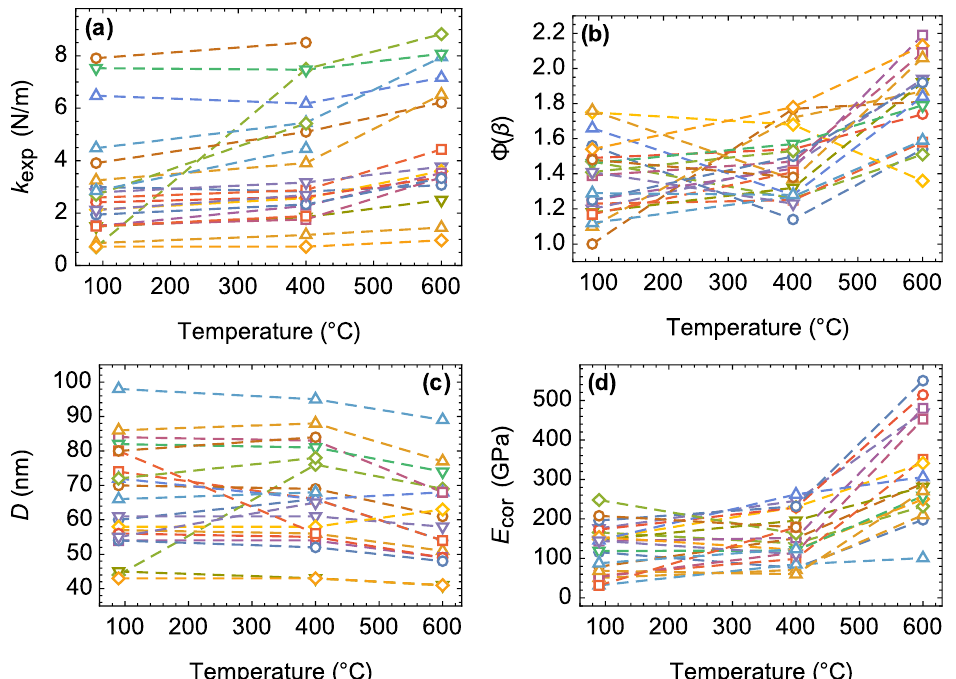
Figure 5. Changes in the main morphological and mechanical characteristics of individual nano- bridges with an increase in heat treatment temperature: ( a ) bending stiffness, ( b ) Φ(𝛽) parameter, ( c ) outer diameter, and ( d ) the Young’s modulus 𝐸 cor . Each set of 3 points denotes the property alteration of the same nanobridge (see Figure 1).